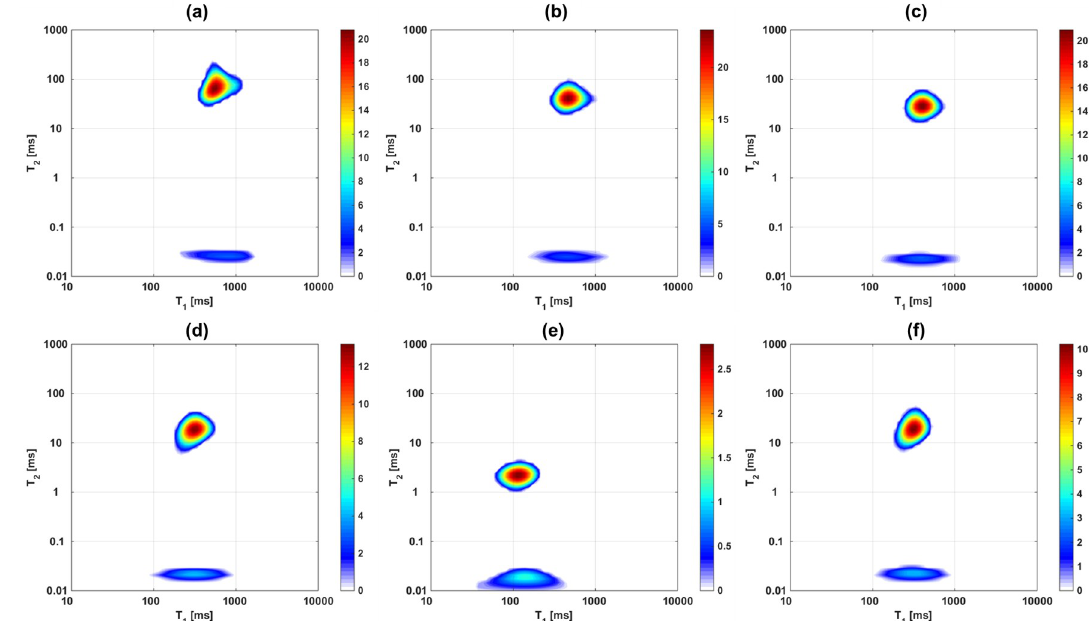
Fig 2. 1 H T 1 -T 2 maps of one cartilage sample as it undergoes drying and then rehydration: a) D1, b) D2, c) D3, d) D4, e) D5, the mass remains constant after this stage, f) Re1. The secondary peak (at shorter T 2 times) appears and increases in relative intensity as the main peak decreases in intensity and shifts towards lower T 1 and T 2 values.